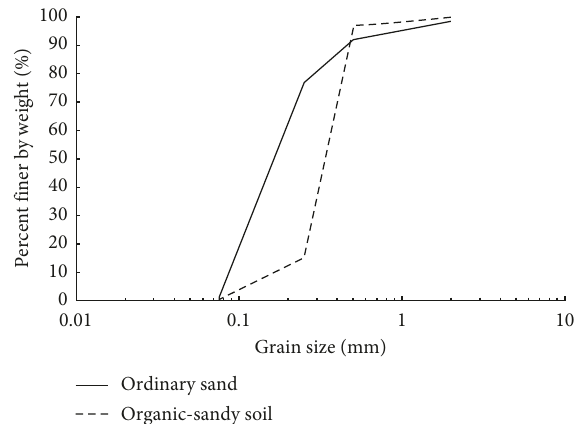
Figure 5: Grain size distribution curves of ordinary and organic sandy soils.